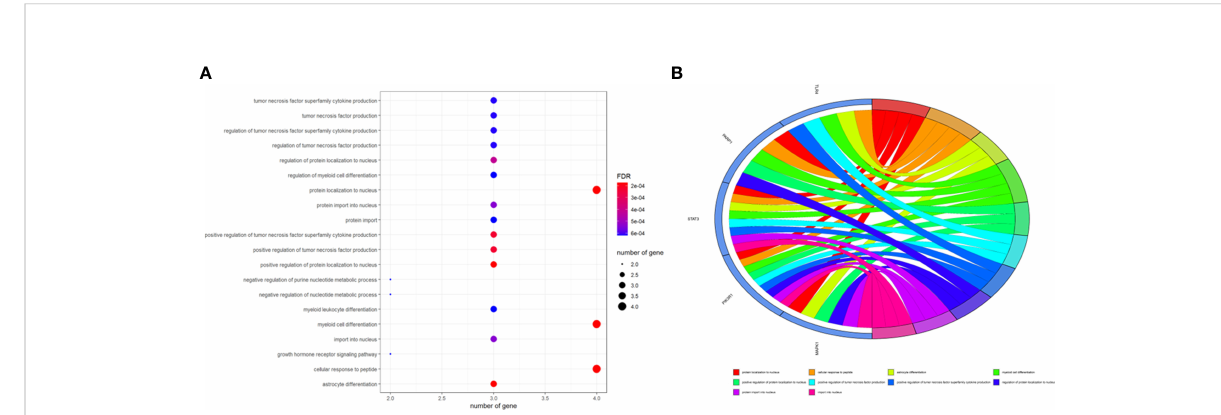
FIGURE 3 The main terms for biological process, cellular component, and molecular function are presented using bar plots (A) . The top terms of the functional enrichment analysis are displayed through the bubble chart (B)